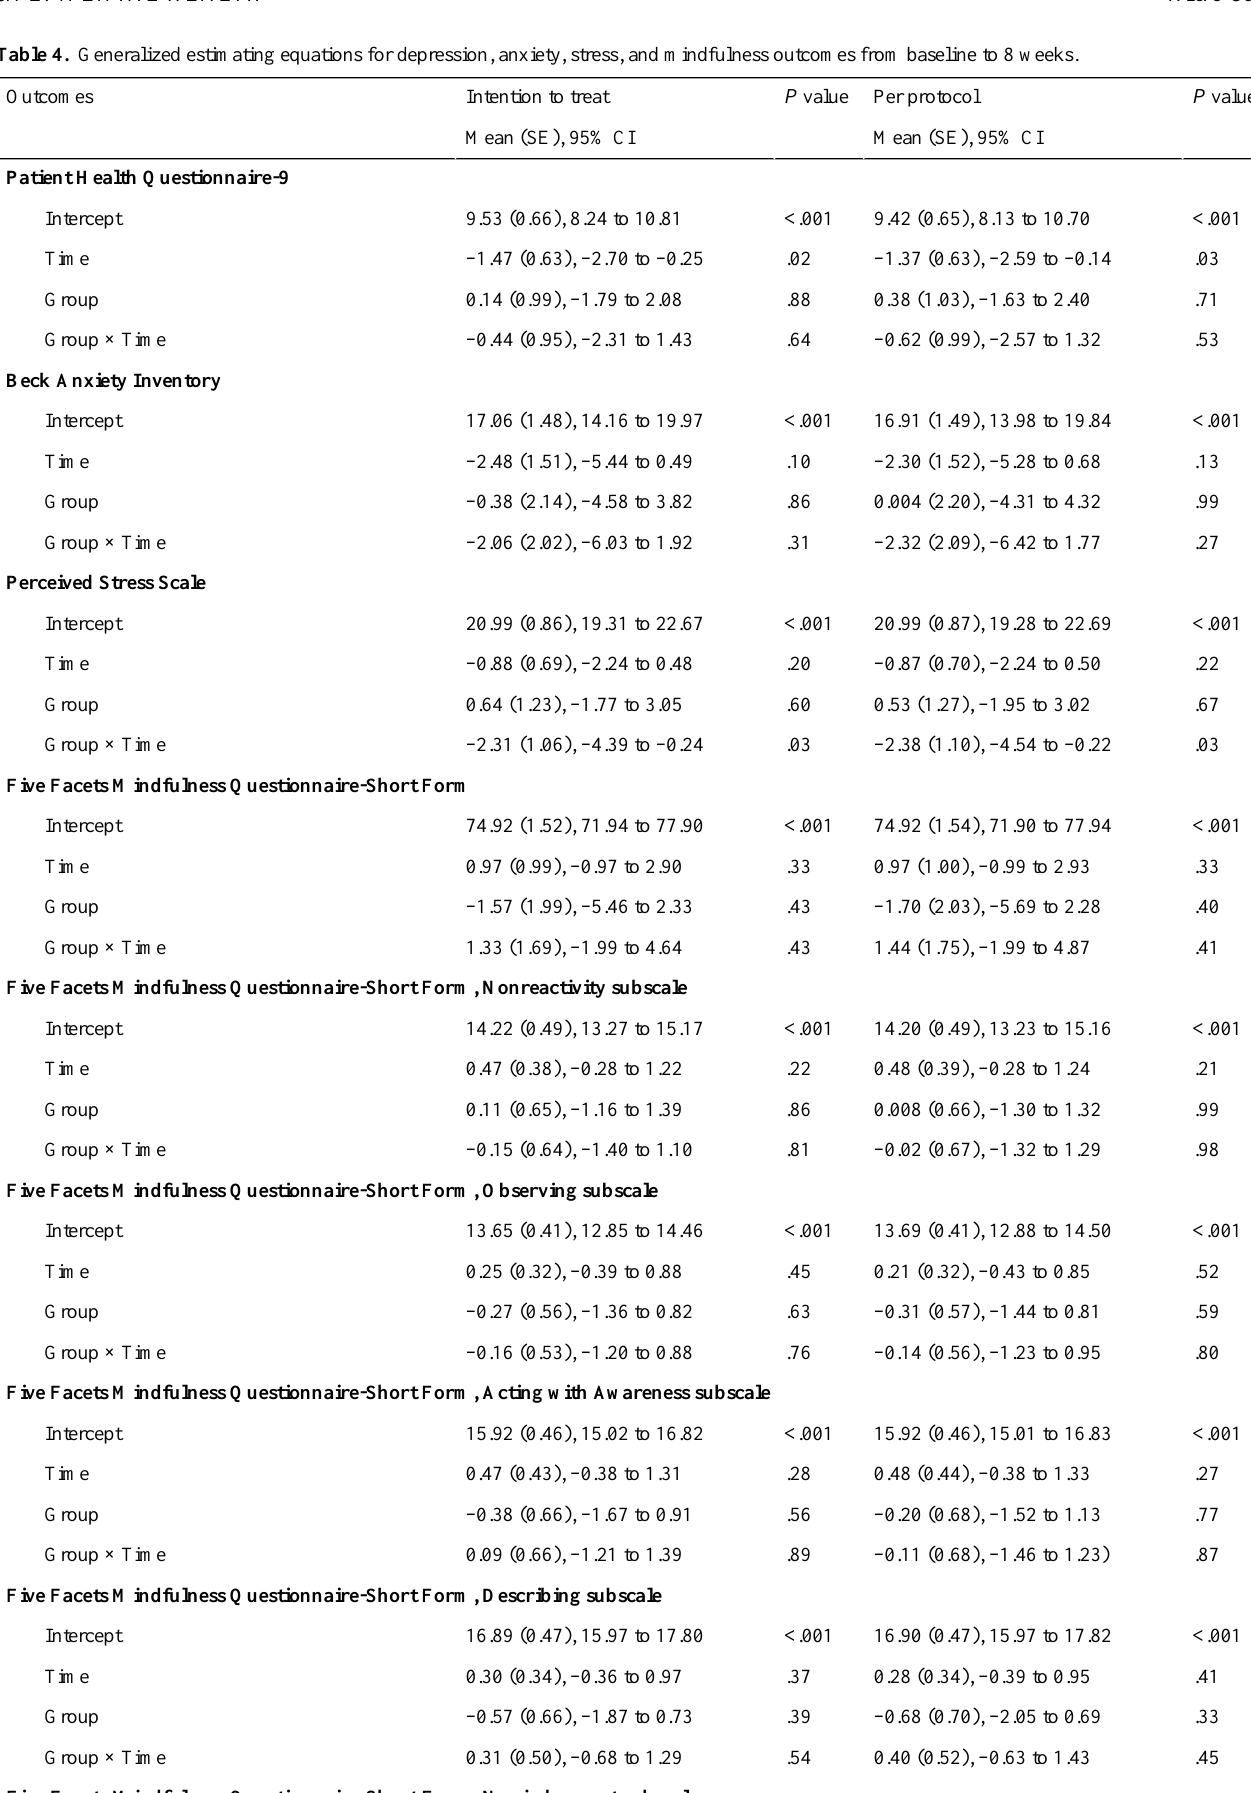
Table 4. Generalized estimating equations for depression, anxiety, stress, and mindfulness outcomes from baseline to 8 weeks.